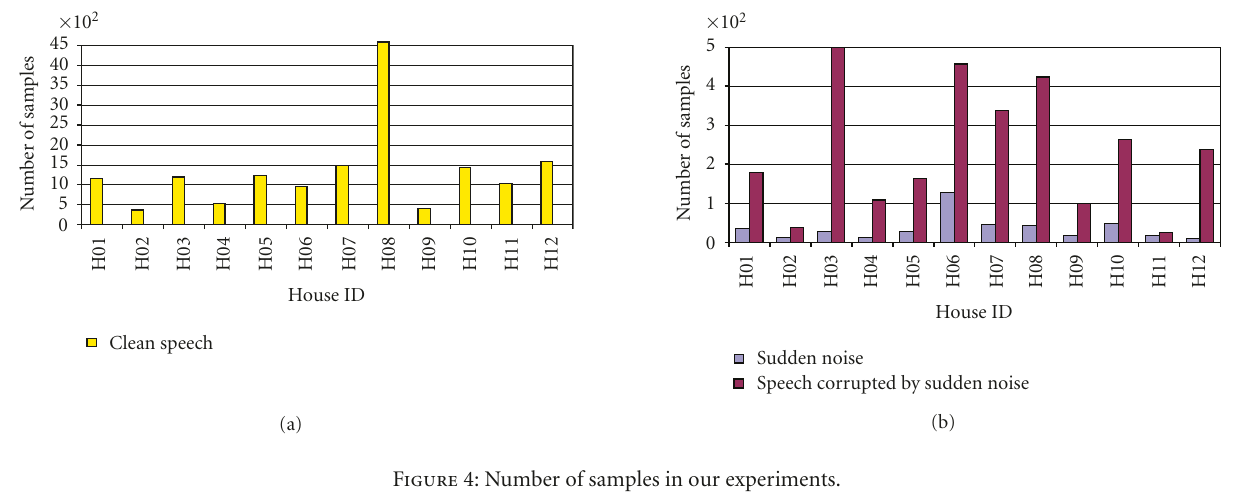
Figure 4: Number of samples in our experiments.